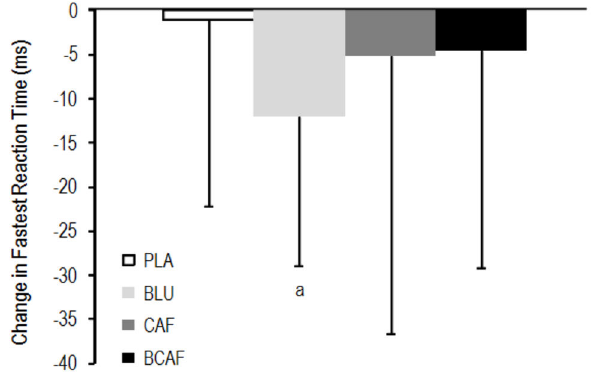
Figure 5. Change in performance of the visual reaction time task. a: small difference from PLA. PLA: white light/ placebo; CAF: white light/240 mg caffeine; BLU: blue light/ placebo; BCAF: blue light/240 mg caffeine.